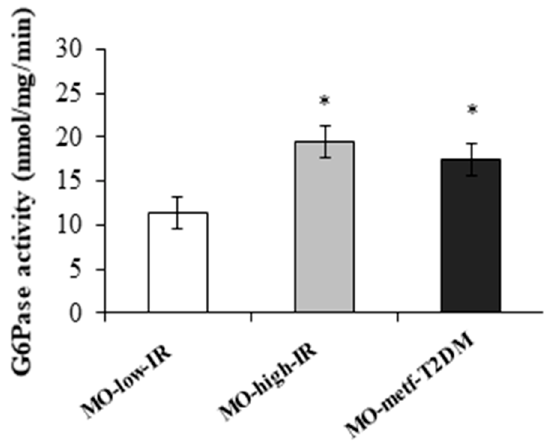
Figure 3. Enzymatic activity of G6Pase in the jejunum of MO-low-IR ( n = 5), MO-high-IR ( n = 5) and in MO-metf-T2DM ( n = 5). The results are given as mean ± SEM. * p < 0.05: significant differences with regard to MO-low-IR group.